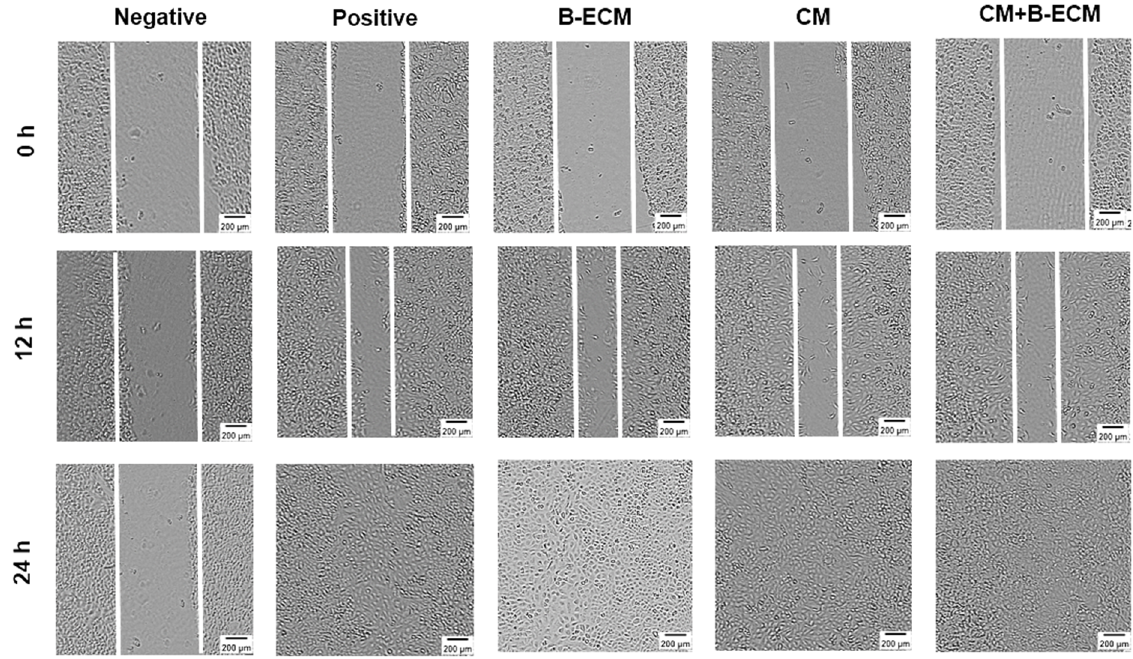
Figure 8. Wound healing assay of A549 cells after 12 and 24 h (scale bar = 200 µm).